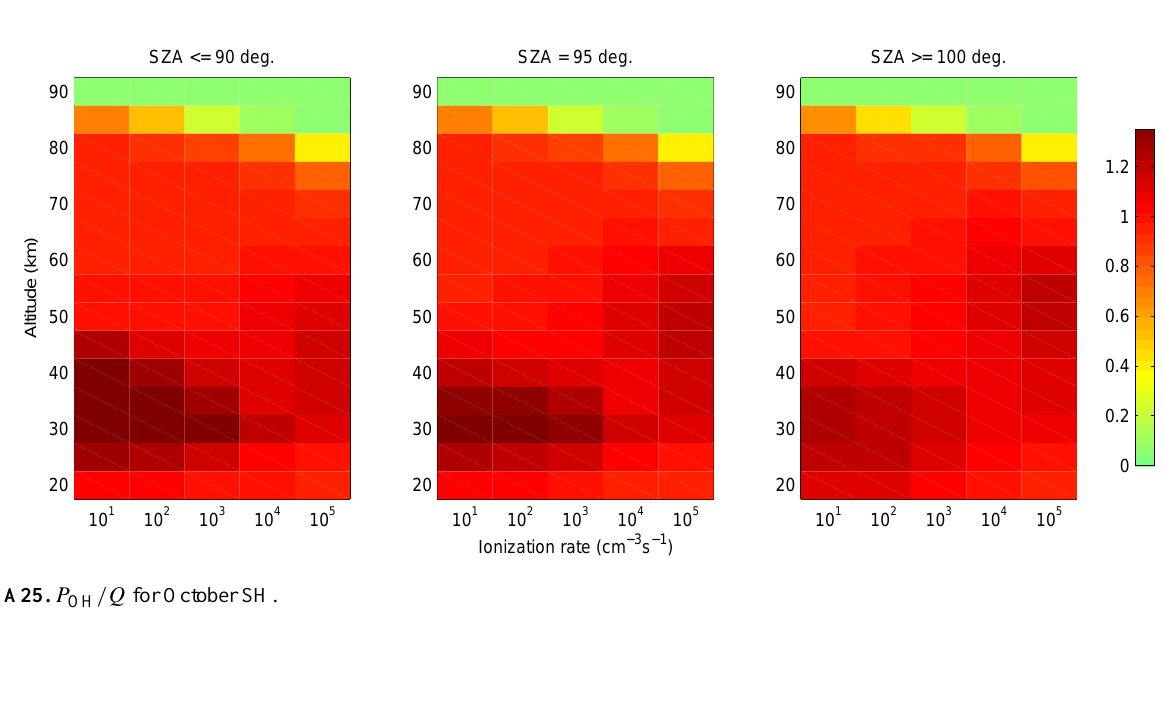
Fig. A25. P OH /Q for October